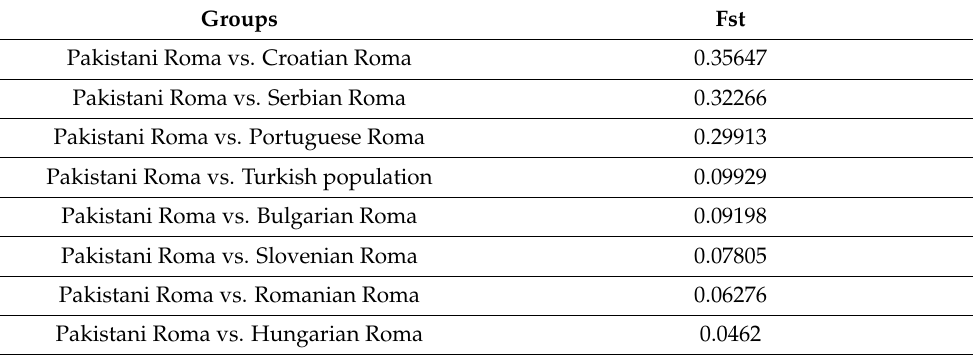
Table 1. Analysis of molecular variance (AMOVA) using Y STRs between groups of populations. Groups